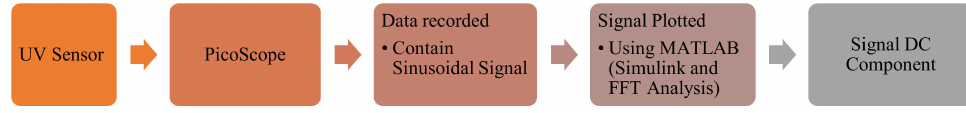
Figure 5. Flow to determine the DC Component of the UVP